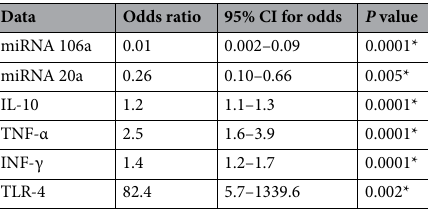
Table 6. Univariate logistic regression analysis for the study biomarkers in in COVID-19 patients versus controls. OR Odds ratio, CI Confidence interval. Significant level at P value <